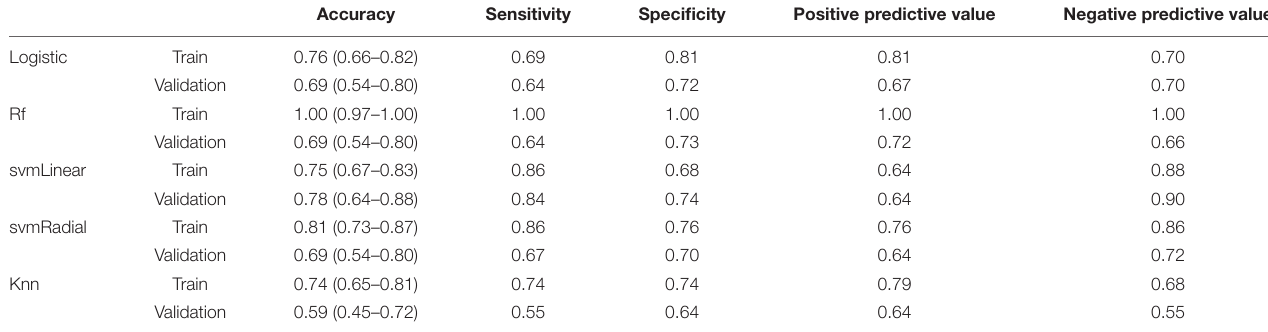
TABLE 2 | The statistical parameters of the training and validation set.